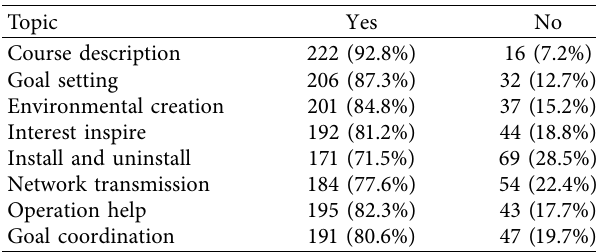
Figure 1: AHP PSO-BP online teaching quality evaluation framework. Table 3: Factors matrix of PSO-BP online course quality